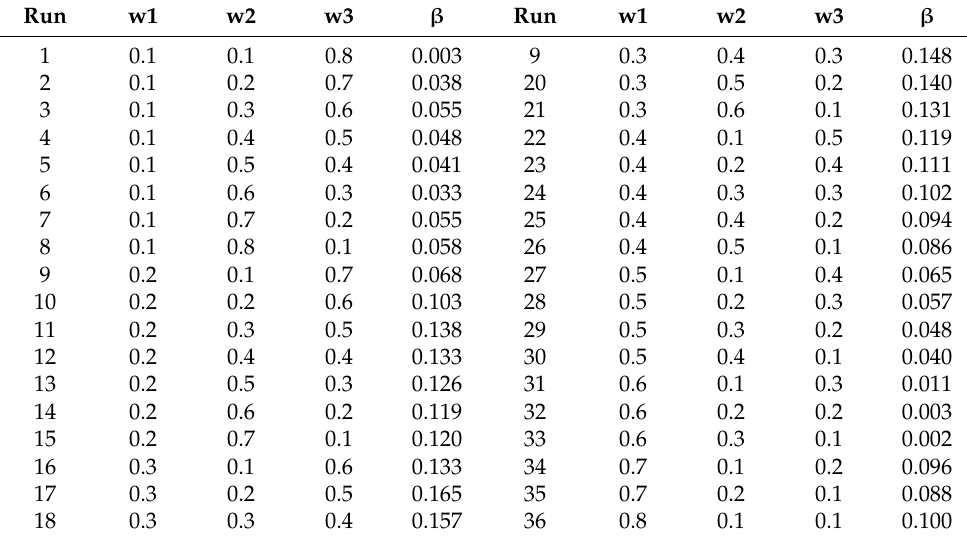
Figure 4. Results of LEX method: ( a ) F1 vs. F2; ( b ) F1 vs. F3; ( c ) F2 vs. F3; ( d ) 3D plot. Table 3. Weight values and results of the NBI